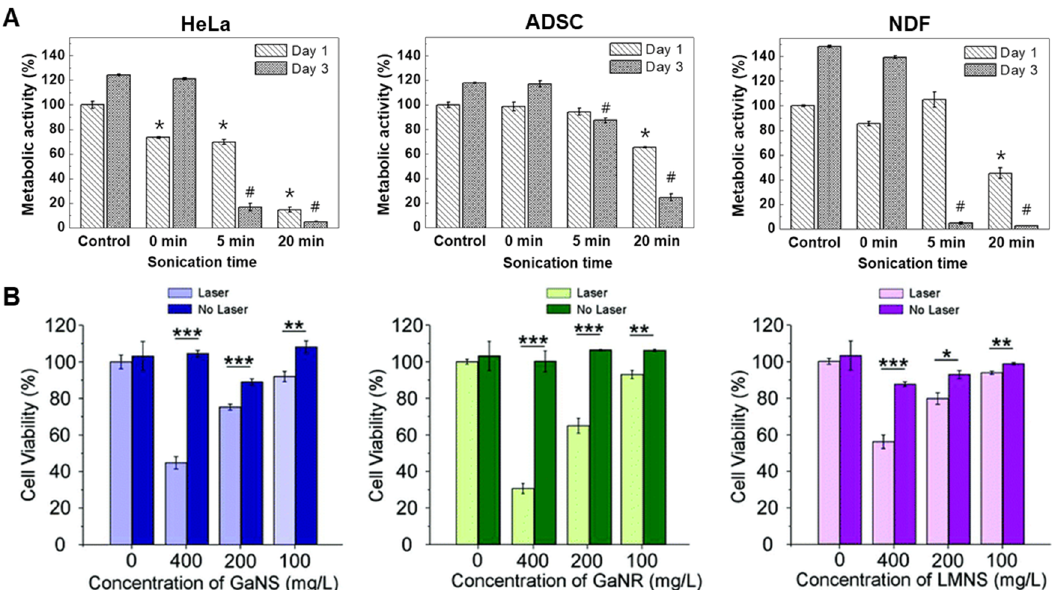
Figure 4. Cytotoxicity evaluation of LMNPs. ( A ) Metabolic activity of HeLa cells, ADSCs, and NDFs exposure to EGaIn releasates at different sonication time. * and # indicate significant differences as compared with day 1 and 3 controls (cells with no EGaIn releasates), respectively ( p < 0.05). Reproduced with permission from ACS [46]. ( B ) Cell viability of MDA-MB-231 cells cultured with GaNS, GaNR and LMNS at a concentration of 400 mg / L. The external laser used was 1.5 W for 4 min. * p < 0.05, ** p < 0.01, and *** p < 0.001 compared with the control group. Reproduced with permission from RSC [12].